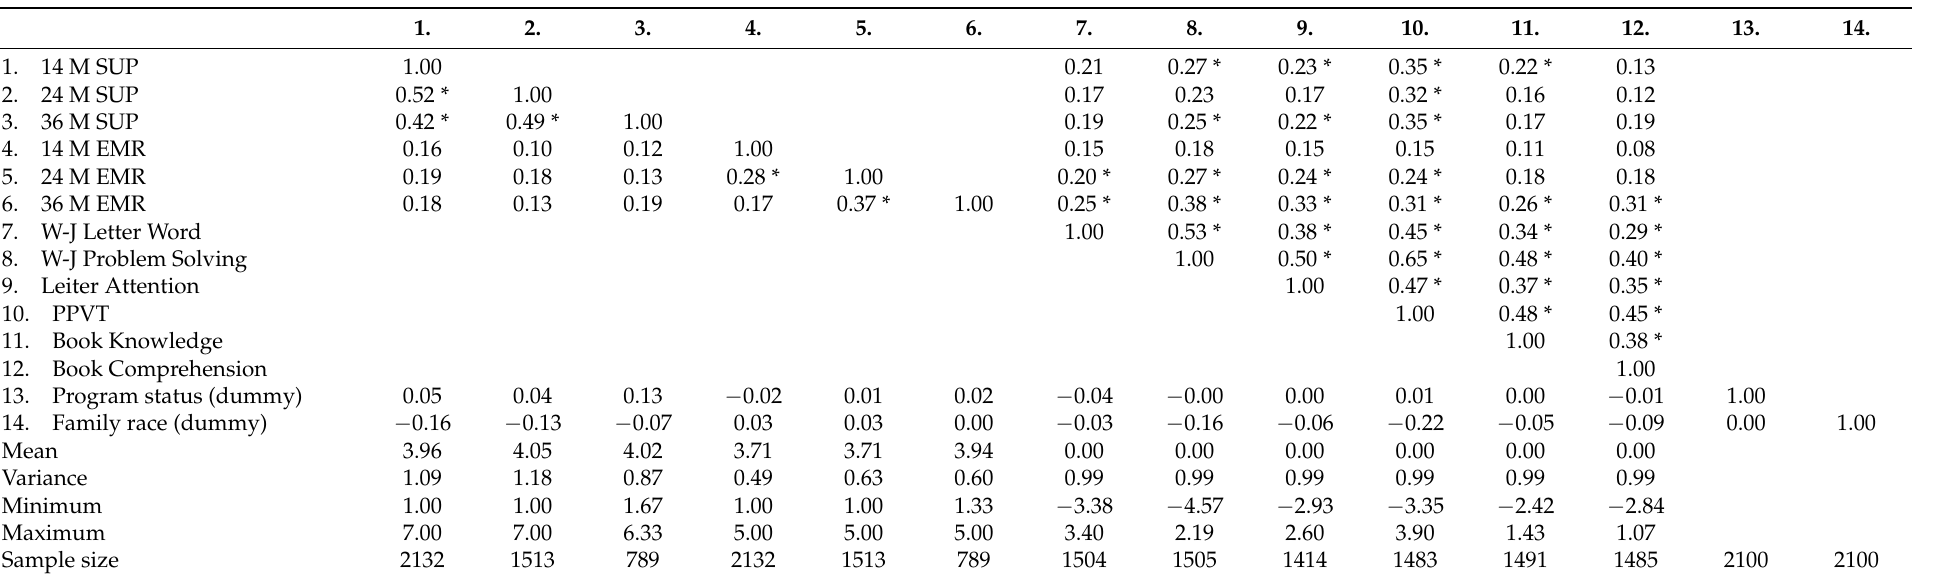
Table 2. Descriptive Statistics and Correlations for the Study